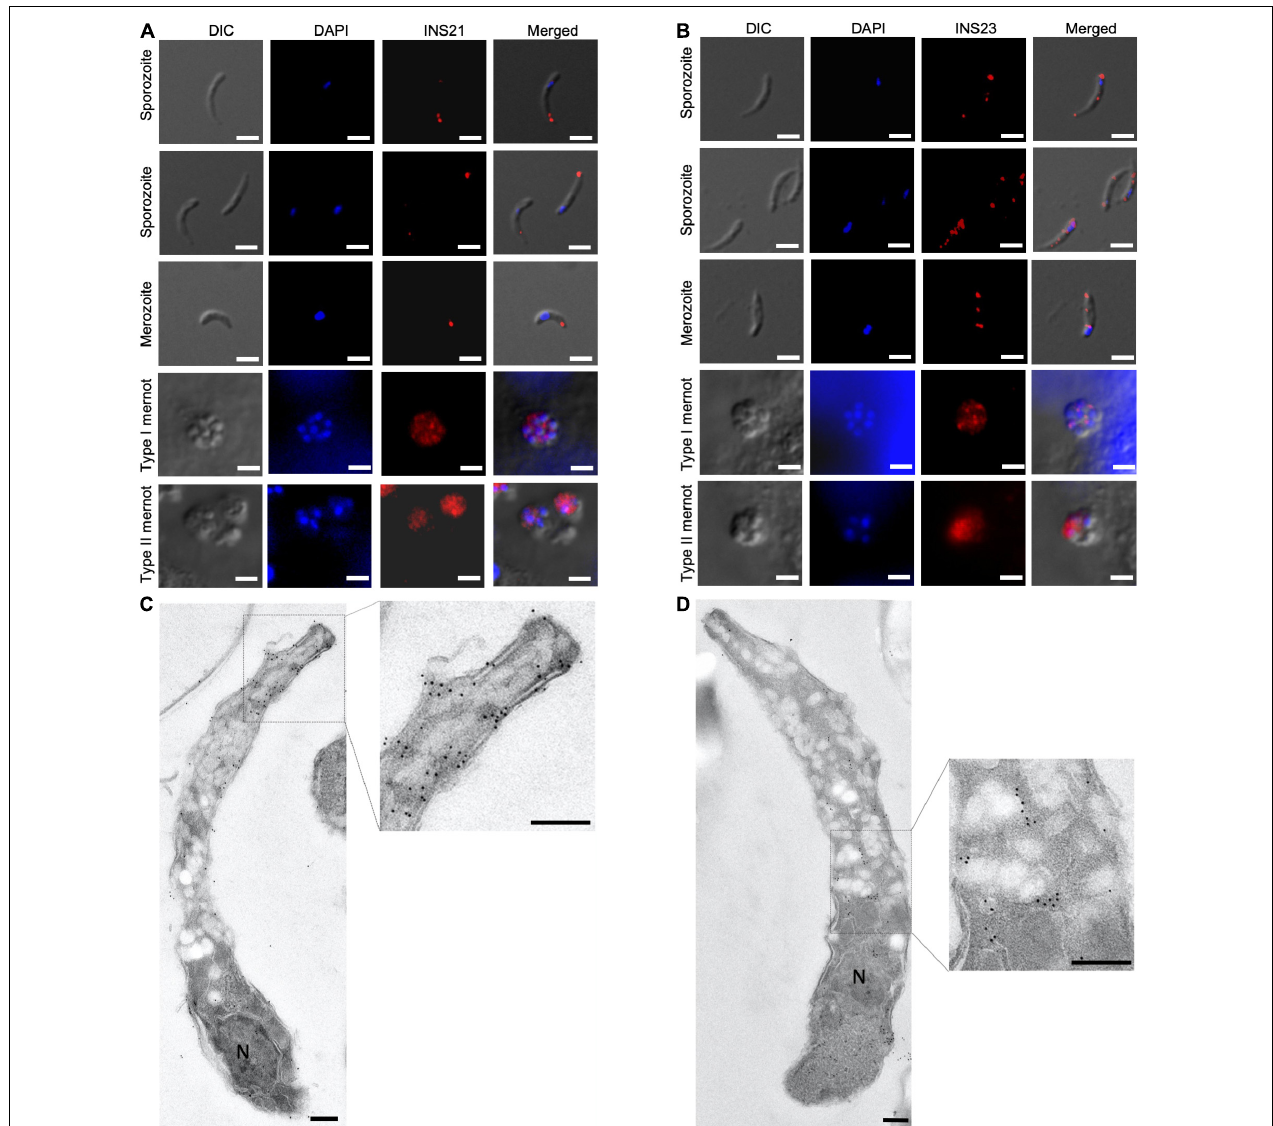
FIGURE 5 | Expression of INS proteins in C. parvum life cycle stages indicated by immunofluorescence and transmission electron microscopy. Expression of INS-21 (A) and INS-23 (B) in C. parvum sporozoites and intracellular developmental stages in HCT-8 cell cultures, such as merozoites, type I meronts, and type II meronts, was examined using immunofluorescence microscopy. The images were taken under differential interference contrast (DIC), with the nuclei being counter-stained with 4’,6-diamidino-2-phenylindole (DAPI), parasites stained by immunofluorescence with anti-INS antibodies, and superimposition of the three images (Merged). Scale bars = 2 µ m. In addition, the expression of the two INS in sporozoites was examined using transmission electron microscopy with anti-INS-21 antibodies (C) or anti-INS-23 antibodies (D) followed by the use of 18-nm colloidal gold-labeled goat anti-rabbit IgG. N, nucleus; AC, apical complex. Scale bars = 200